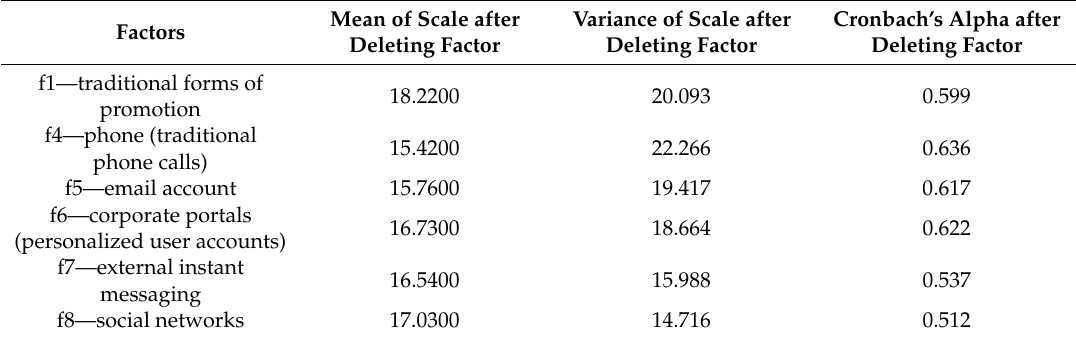
Table 7. Main factors of the complexity of communication with customers—Cronbach’s alpha statistics.